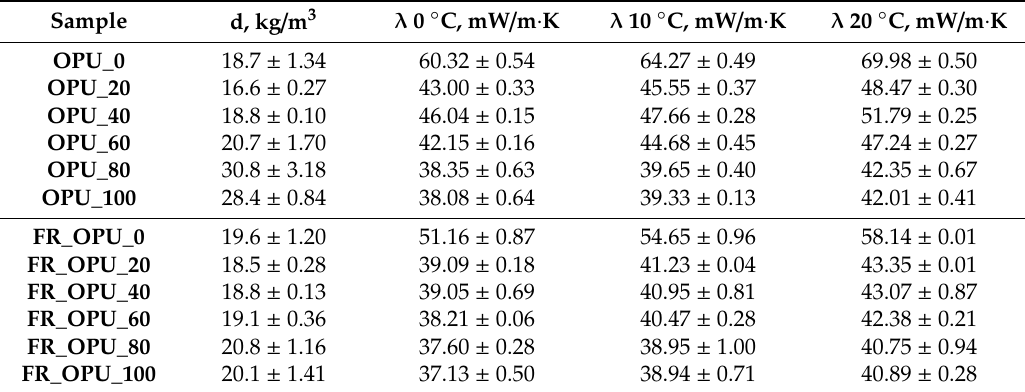
Table 2. Apparent density and coe ffi cient of thermal conductivity of open-cell PUR foams.